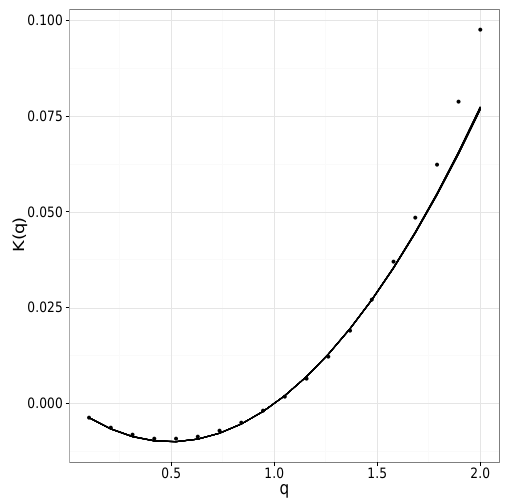
Figure 5. The empirical moments M q as a function of scale for Figure 6. The empirical function K(q) , together with the fitted storm 1 in its entirety. The moments show good scaling character- Fig. 5. The empirical moments M q as a function of scale for storm 1 in its entirity. The moments show Fig. 6. The empirical function K ( q ) , together with the fitted function using the WMA method. The function using the WMA method. The empirical function crosses istics as evidenced by the good fit of the linear function for each of good scaling characteristics as evidenced by the good fit of the linear function for each of the moments empirical function crosses zero for K (0) because of the use of the WMA method. Above q zero for K( 0 ) because of the use of the WMA method. Above the moments q . q . starts to diverge from the empirical function, suggesting that above q = 1 . 5 the scaling breaks and the q ∼ 1 . 5 the fit starts to diverge from the empirical function, suggest- empirical K ( q ) takes on a linear character. ing that above q = 1 . 5 the scaling breaks and the empirical K(q) takes on a linear character. 27